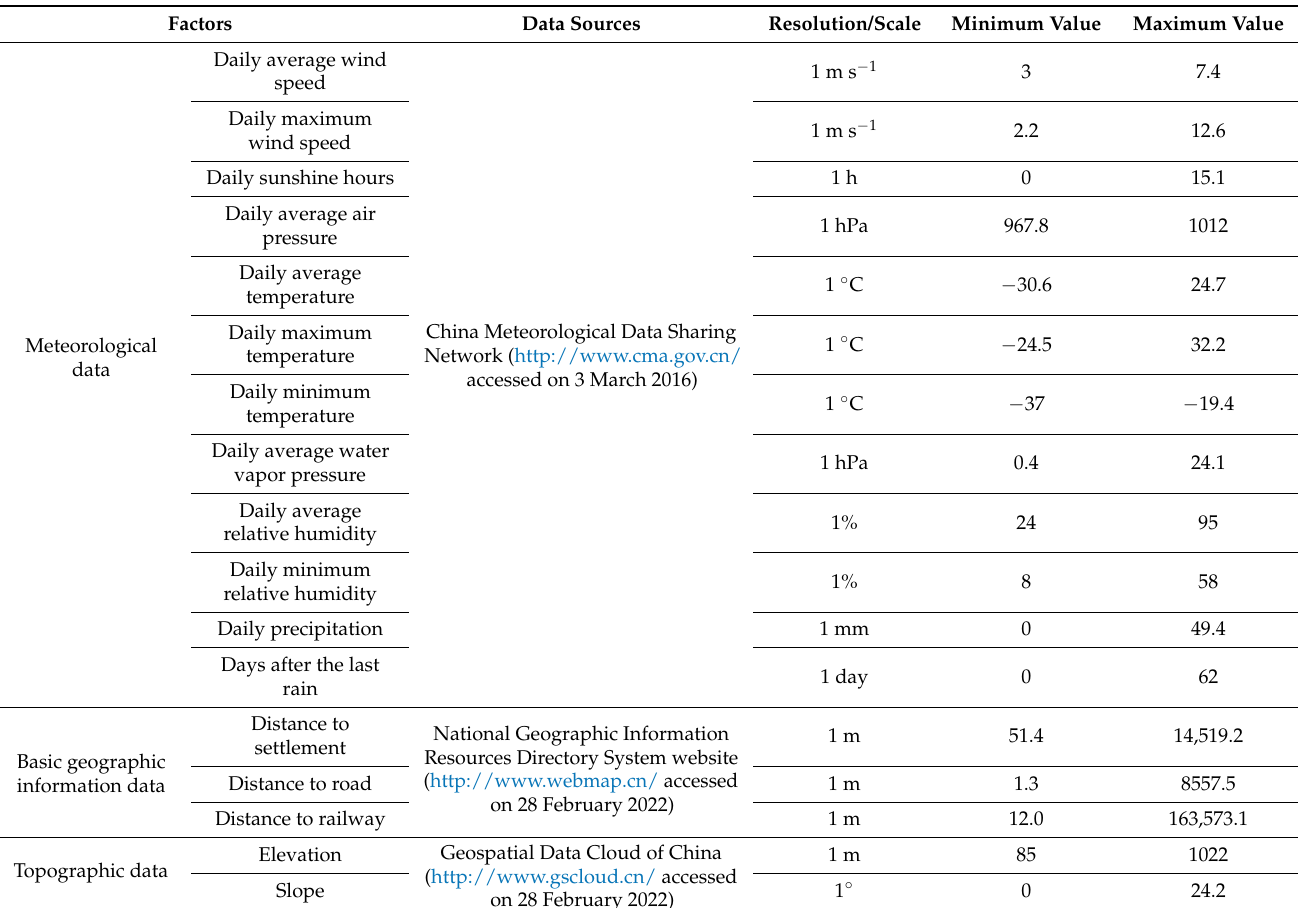
Table 1. The considered forest-fire driving factors in the